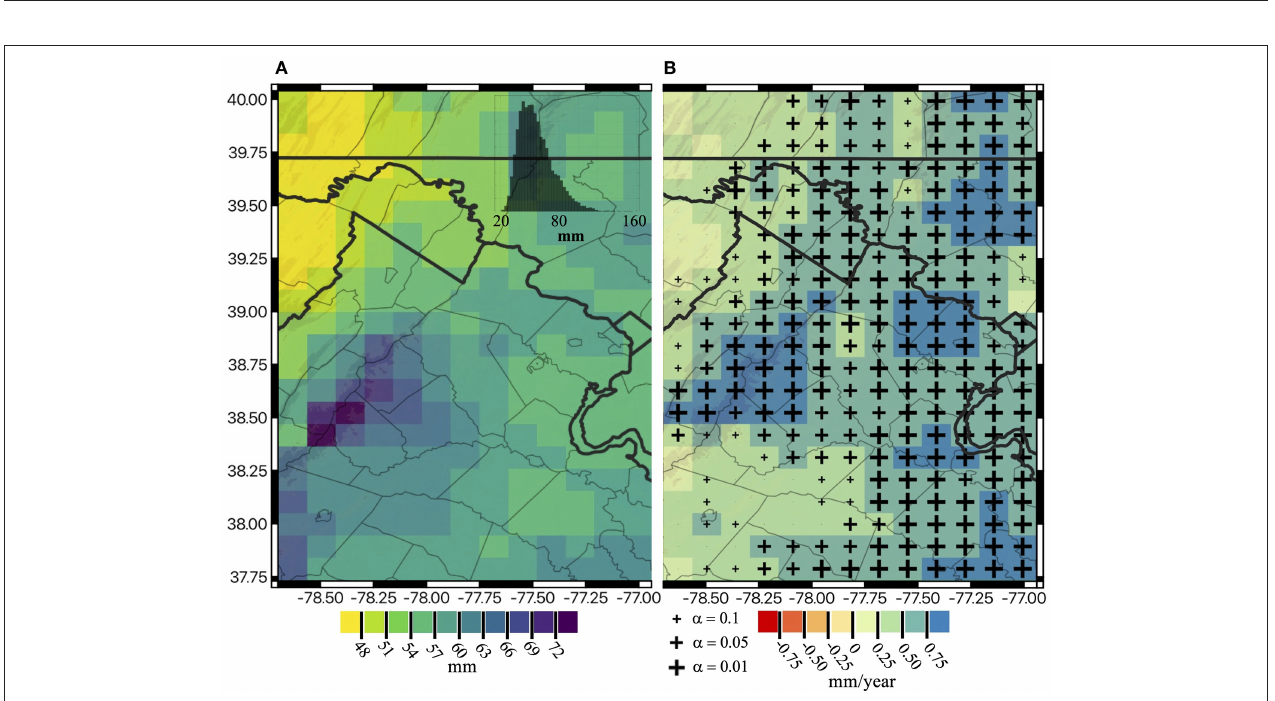
FIGURE 10 | Spatial distribution of extremes and associated trends in extremes (1980–2018) for (A) average 1-day maximum annual precipitation with a histogram in the right corner showing the right skewed distribution of 1-day maximum precipitation for all grids; and (B) Theil-Sen 1-day maximum annual precipitation trend. The size of the cross markers shows the three significance levels used to perform a Mann-Kendall test on the Theil-Sen trends. Markers are not shown in grids with non-significant trends.